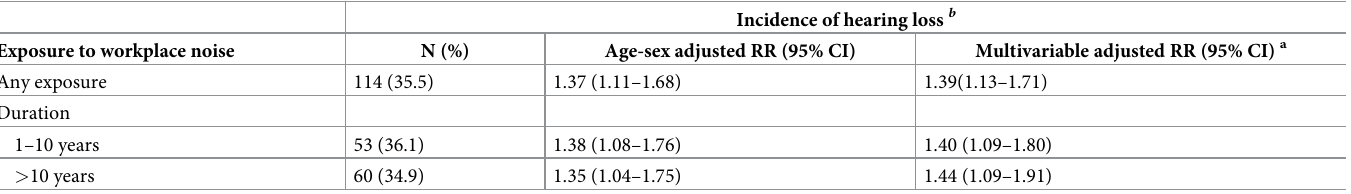
Table 3. Association between exposure to workplace noise and the 10-year incidence and progression of hearing loss, presented as Risk Ratios (RR) and 95% Confi- dence Interval